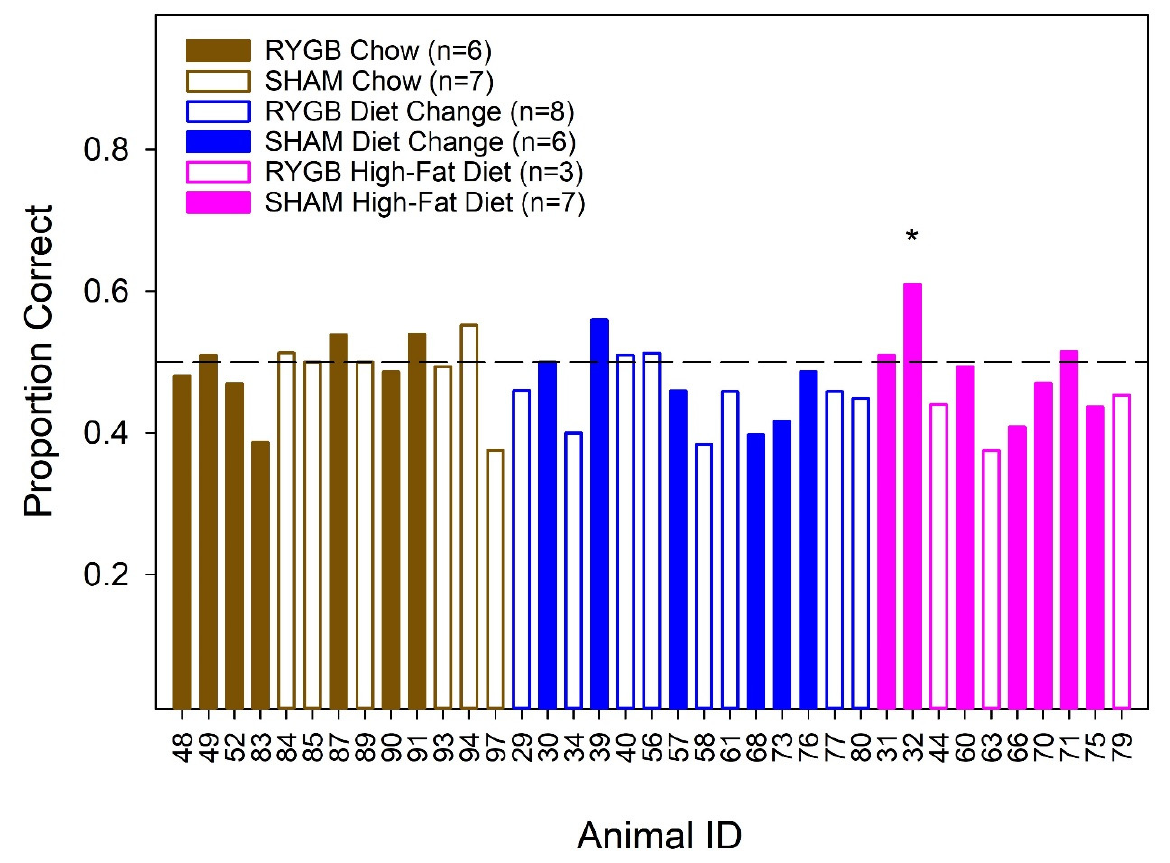
Figure 7. Individual animal performance from the stimulus control test. Filled bars reflect SHAM females and open bars represent the RYGB animals. Brown shading or outlining represent the Chow group; blue, the Diet Change; pink, the High-Fat Diet. One-tailed binomial analyses were used to test for differences greater than chance, represented as significant by “*”. Although the performance of Rat 32 was significantly greater than chance, it was quite poor, and the difference did not survive Bonferroni correction. The horizontal dashed line represents chance performance in this task.